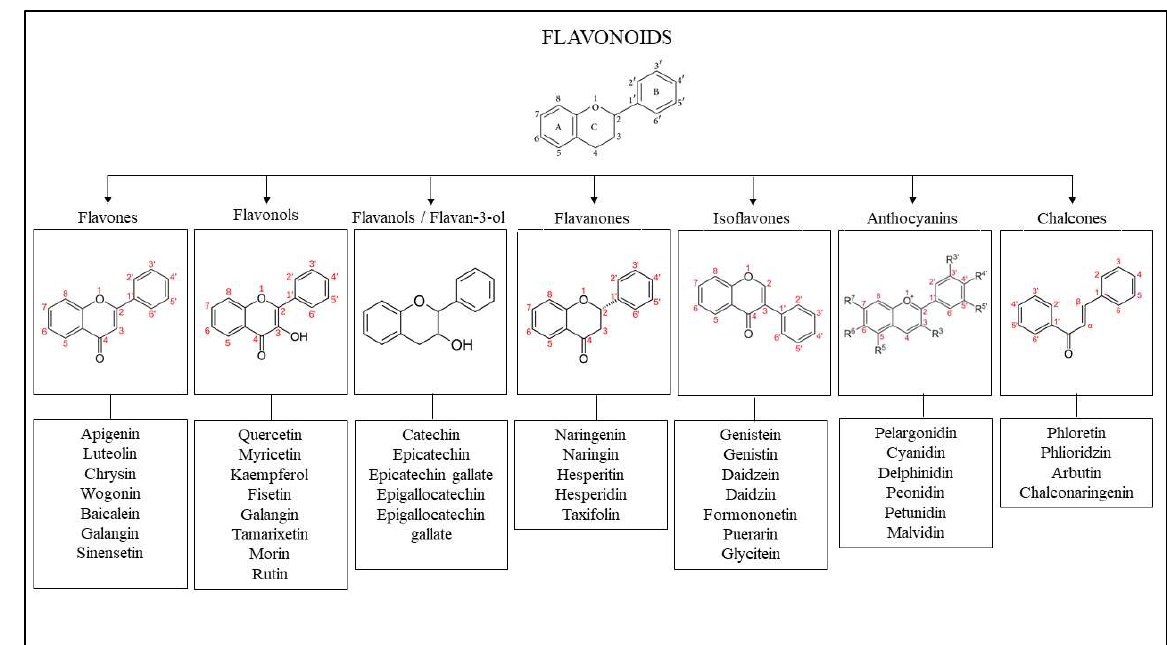
Figure 3. Chemical structures of flavonoids and their major classes along with the examples.